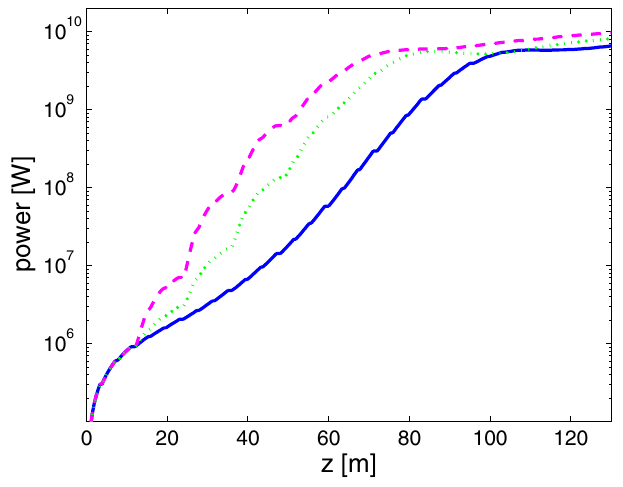
FIG. 5. (Color) SASE FEL power gain along the undulator without any optical klystron (blue solid curve), and with 4 optical klystrons for the initial rms energy spread of 1 (cid:9) 10 (cid:2) 5 (magenta dashed curve) and 5 (cid:9) 10 (cid:2) 5 (green dotted curve). The FEL wavelength is 1 : 5 (cid:1) A , and the undulator parameter K (cid:1) 2 : 7 .